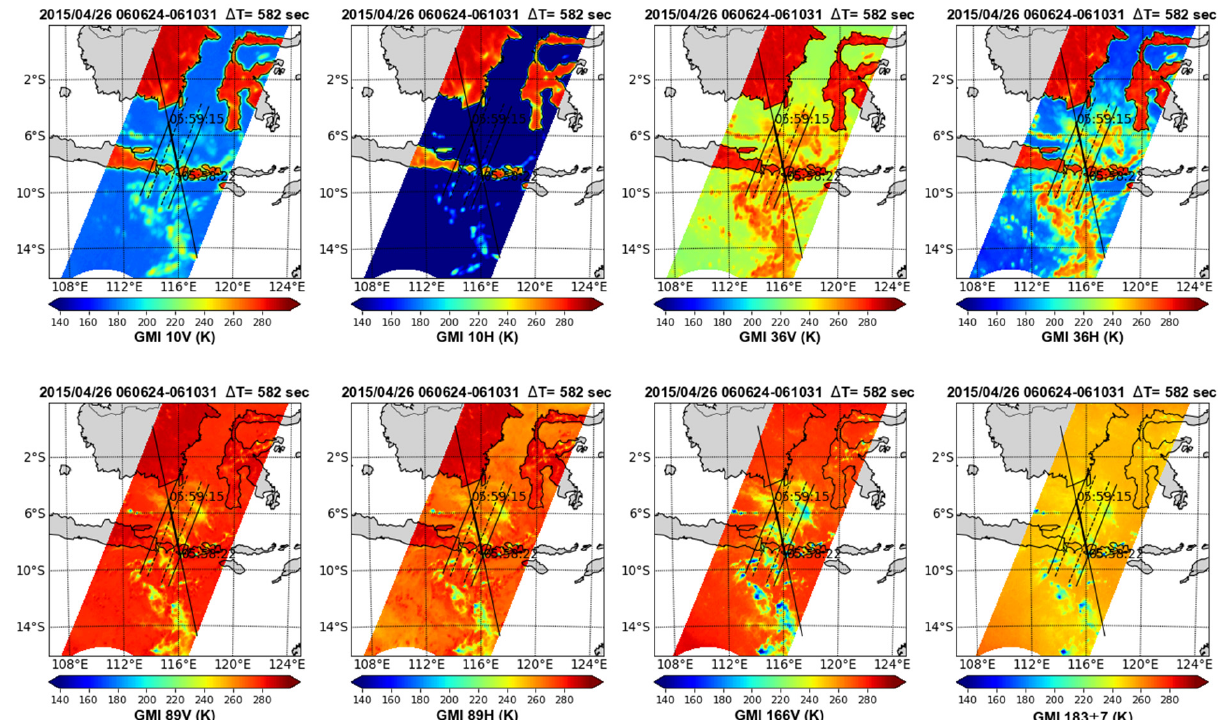
Figure 2. A depiction of a CloudSat-GPM coincidence on 26 April 2015 between 0606 and 0610 UTC, located near the Java Sea. The background represents the GMI TB at (left to right from upper left), 10V, 10H, 36V, 36H, 89V, 89H, 166V and 183 ± 7 GHz, in Kelvin units. The long solid black line represents the CloudSat track across the 931-km GMI swath, and the shorter solid and dashed lines indicate the swath of the DPR Ku- and Ka-band radar, respectively.